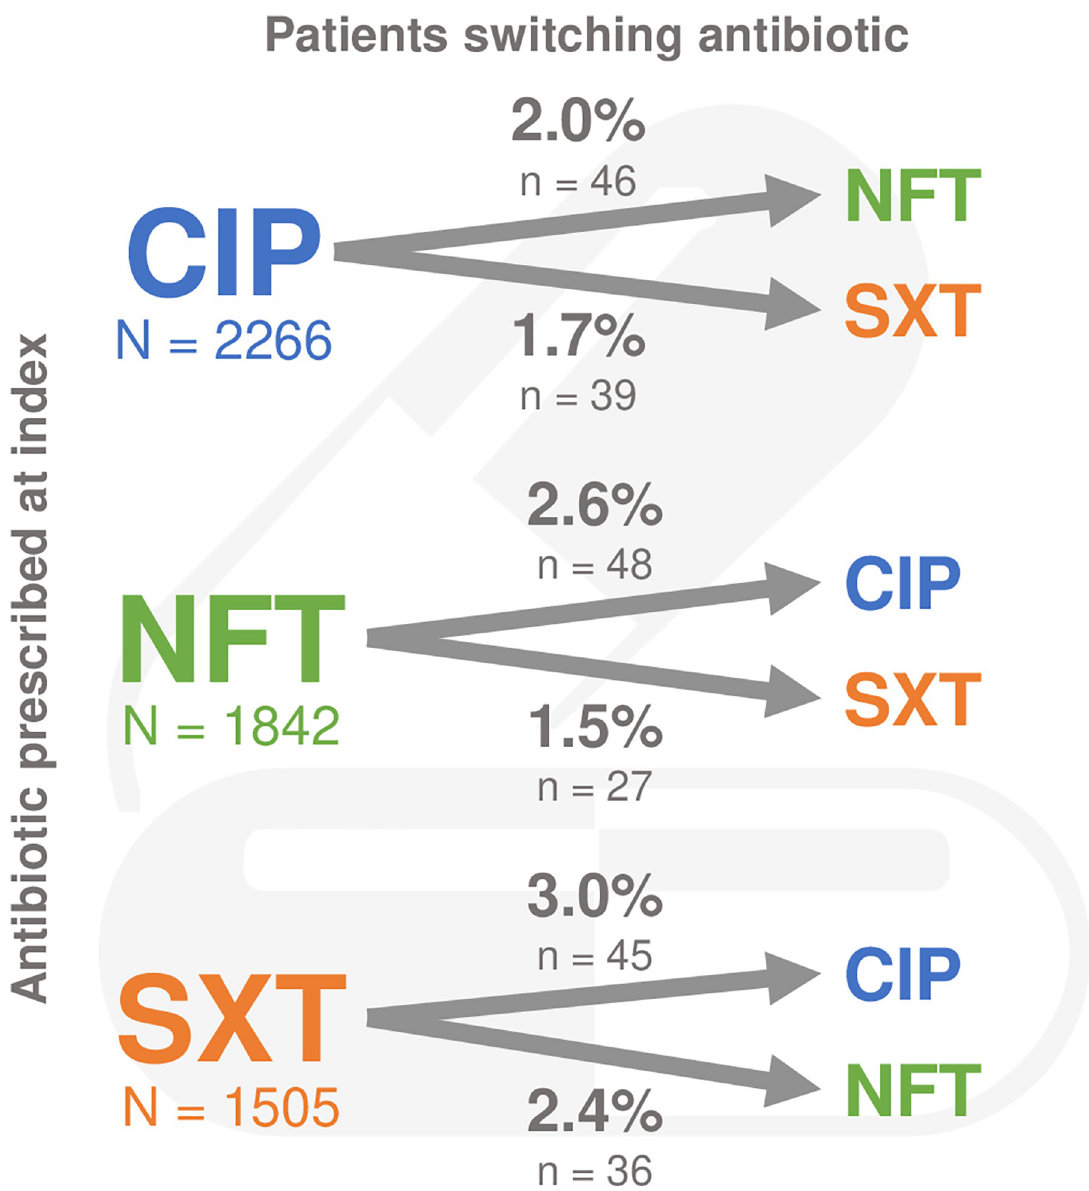
Fig 2. Antibiotic switching patterns at index date. Abbreviations: CIP, ciprofloxacin; NFT, nitrofurantoin; SXT, trimethoprim- sulfamethoxazole.